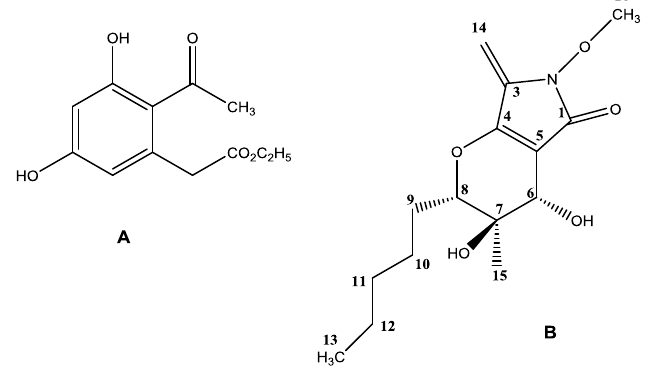
Figure 1. Structures of curvulin ( A ) and phaeosphaeride A ( B ).